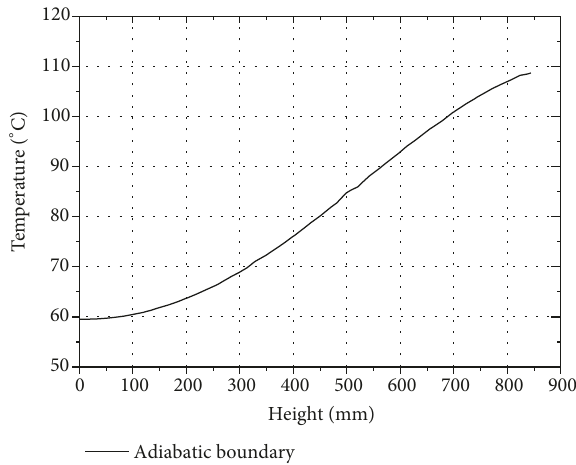
Figure 32: The front plate temperature distribution of support under adiabatic boundary